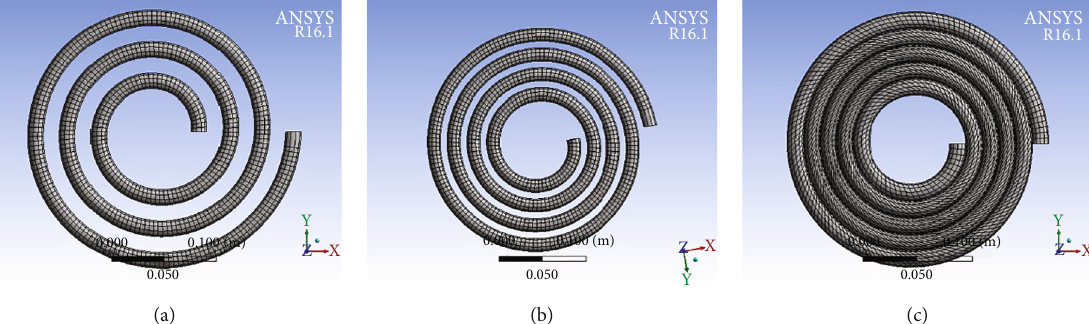
Figure 2: Spiral coil tubular copper absorber mesh on ANSYS 16.1 software as (a) 3 convolutions, (b) 4 convolutions, and (c) 5